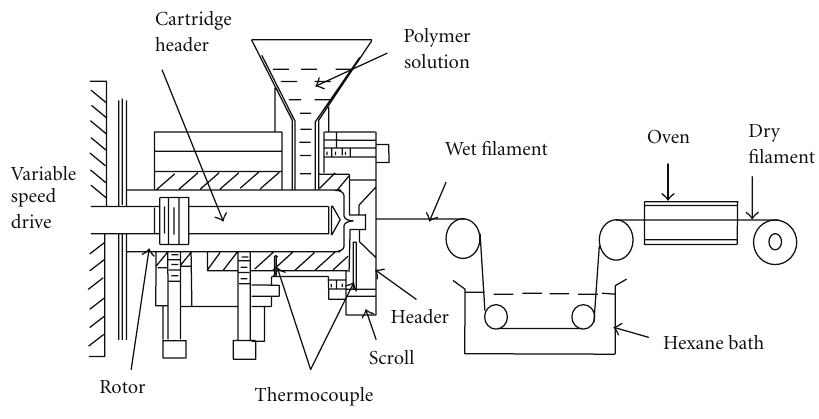
Figure 1: Schematic representation of filament